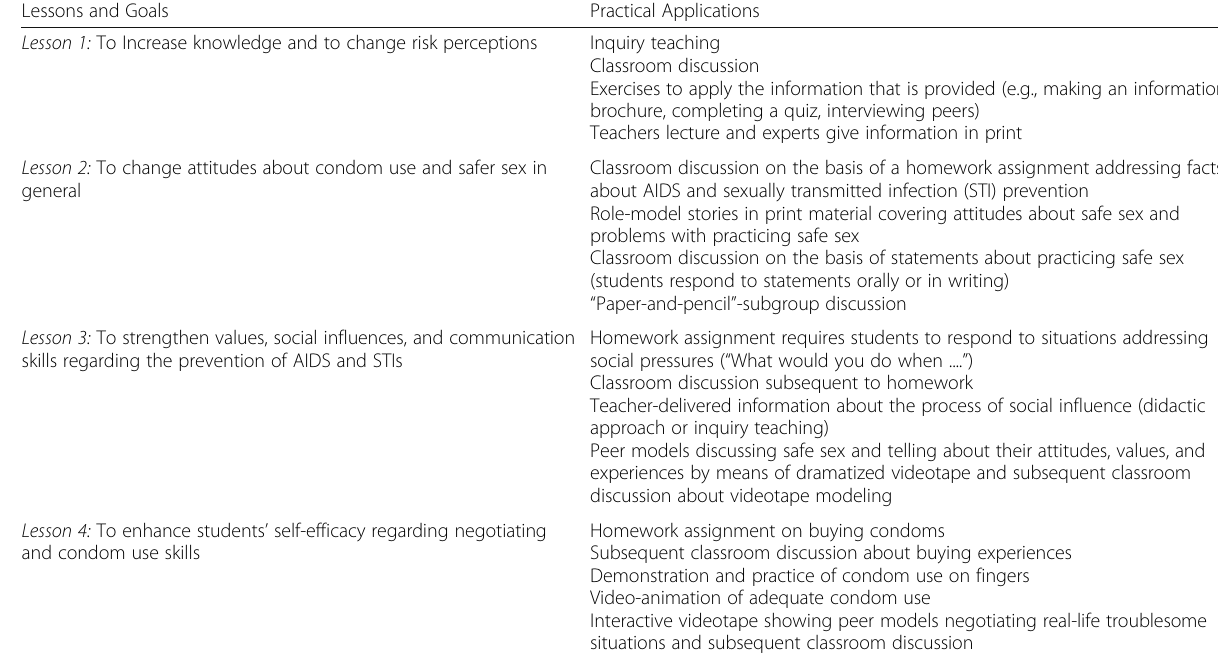
Table 3 Example of program scope and sequence from the Long Live Love sex education program for adolescents (Schaalma et al., 1996) Lessons and